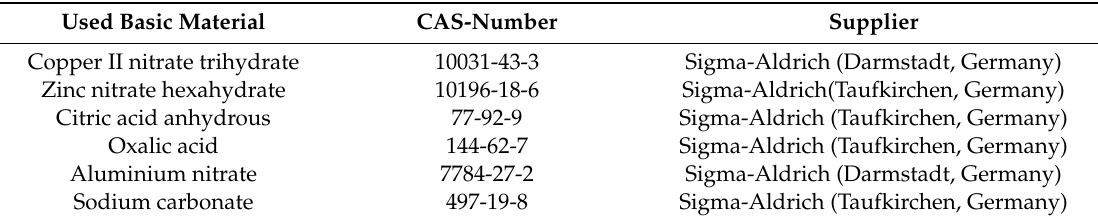
Table 4. List of chemicals used for the catalysts’